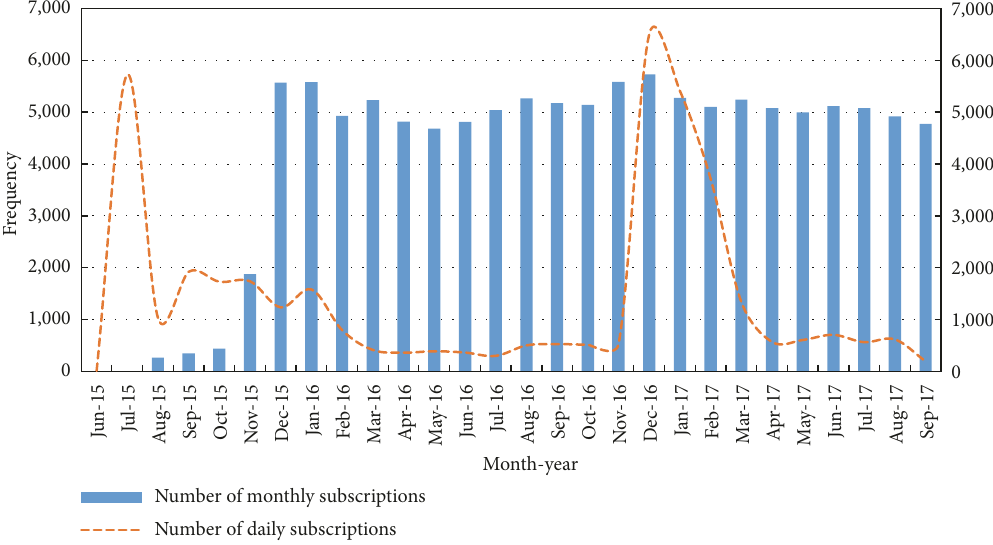
Figure 2: Distribution of the number of daily and monthly subscriptions during the study period (June 2015 to September